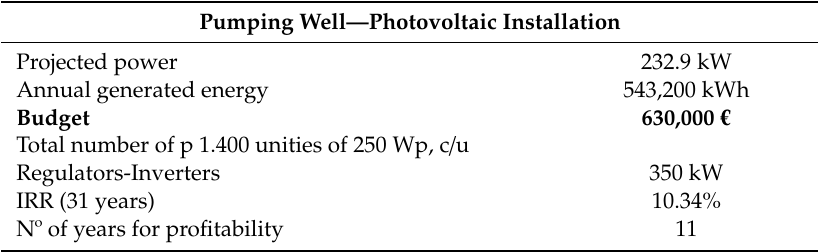
Table 6. Summary of the photovoltaic solar installation of the pumping in the